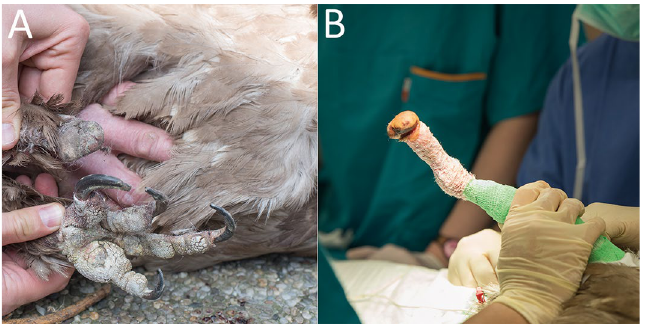
Figure 1. Amputation stump prior to surgery in a bearded vulture. ( A ) Shown is the intact left limb compared to the self-amputated right limb. ( B ) A large formation of granulation scar is visible at the distal end of the amputated limb with chronic ulceration due to heavy load during daily activities.